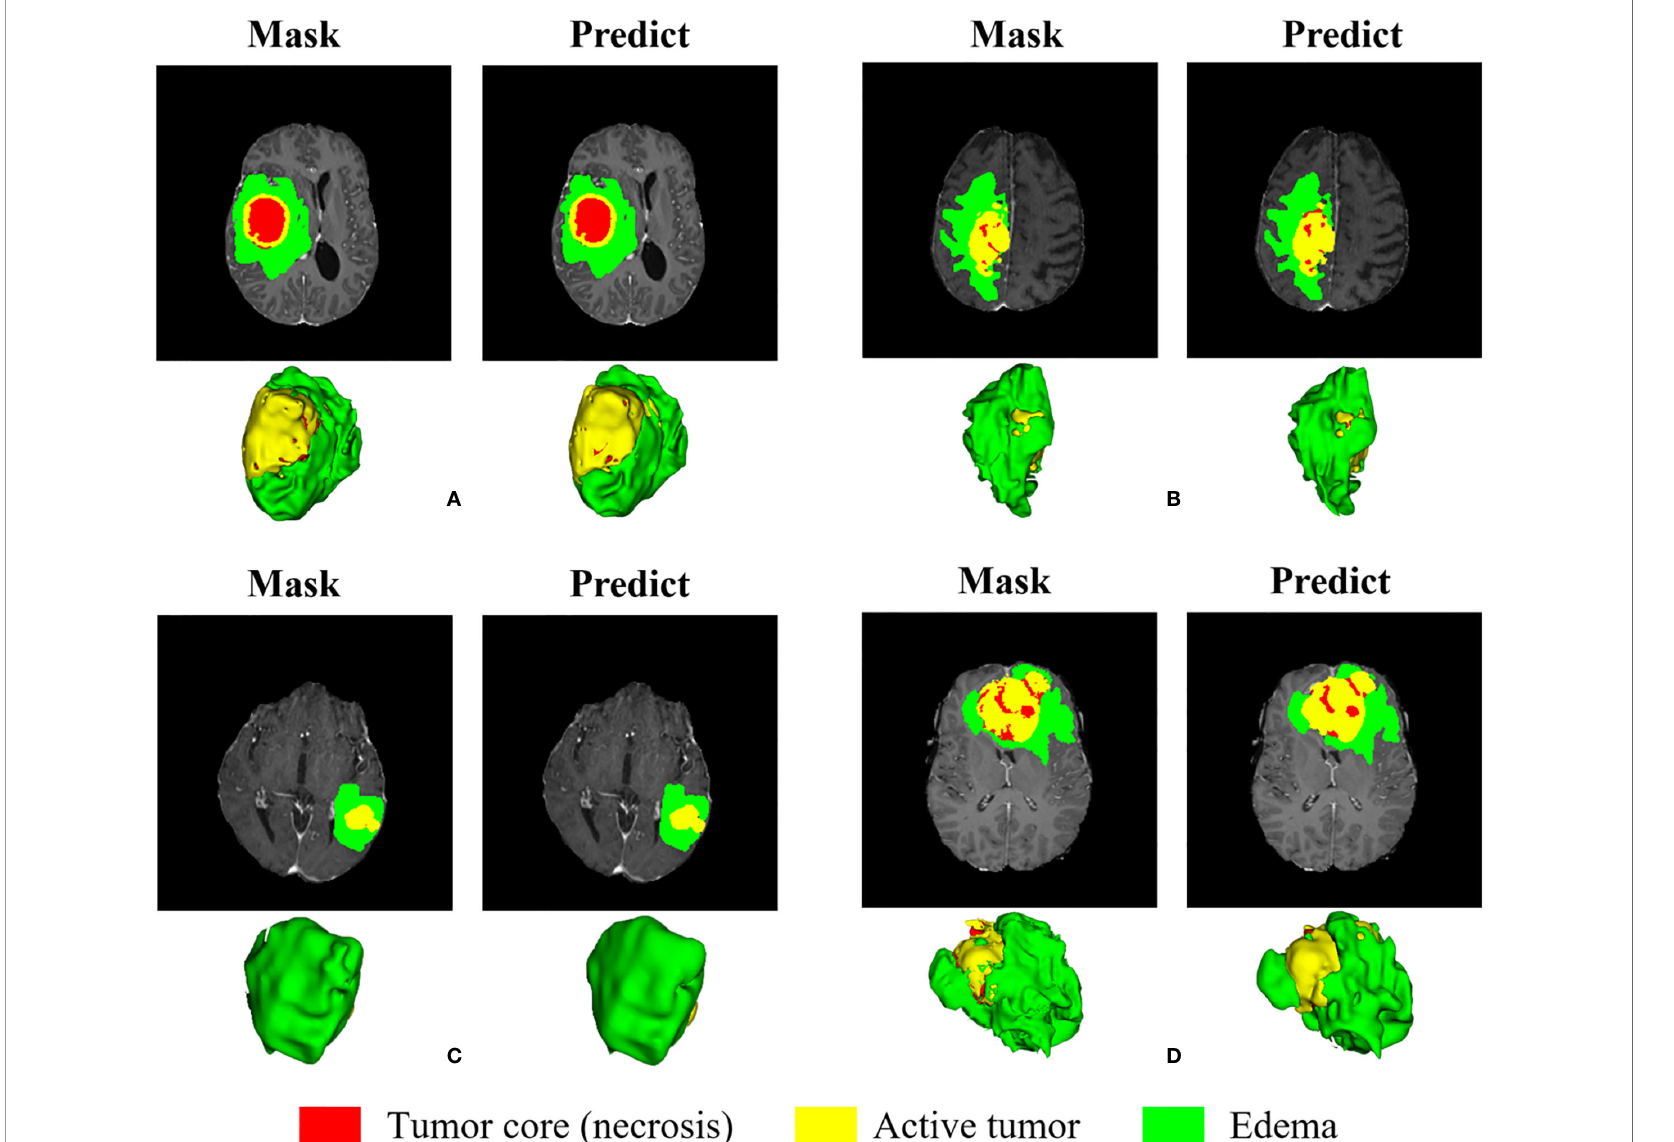
FIGURE 12 | Visual display of brain tumor segmentation results in training set. Red color represents the tumor core (necrosis), yellow color represents the active tumor and green regions are the